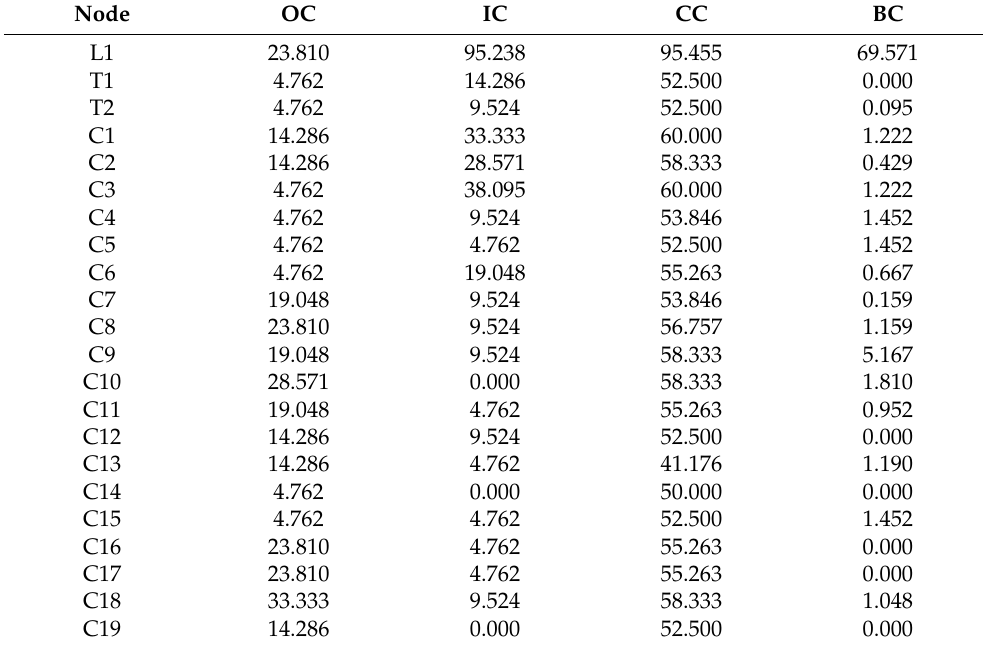
Table 7. The index values of network